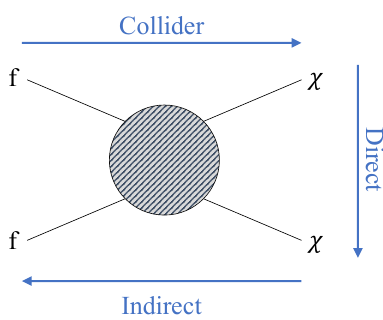
Figure 23. Schematic summary of the complementary approaches used in searches for WIMP